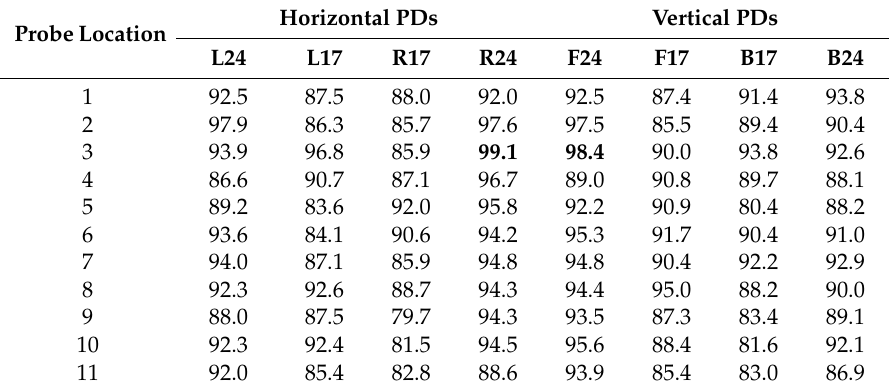
Table 3. Mean HR similarity index [%] for all participants and each LED-PD